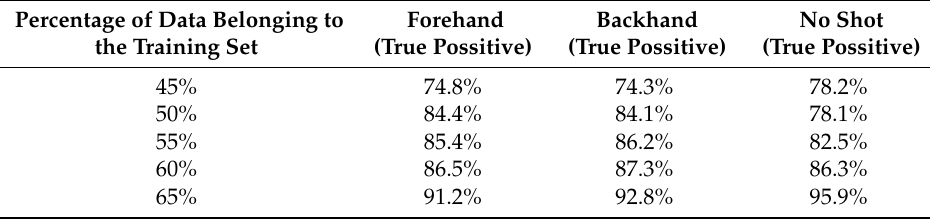
Table 2. Classification results obtained for the Fuzzy ST-GCN